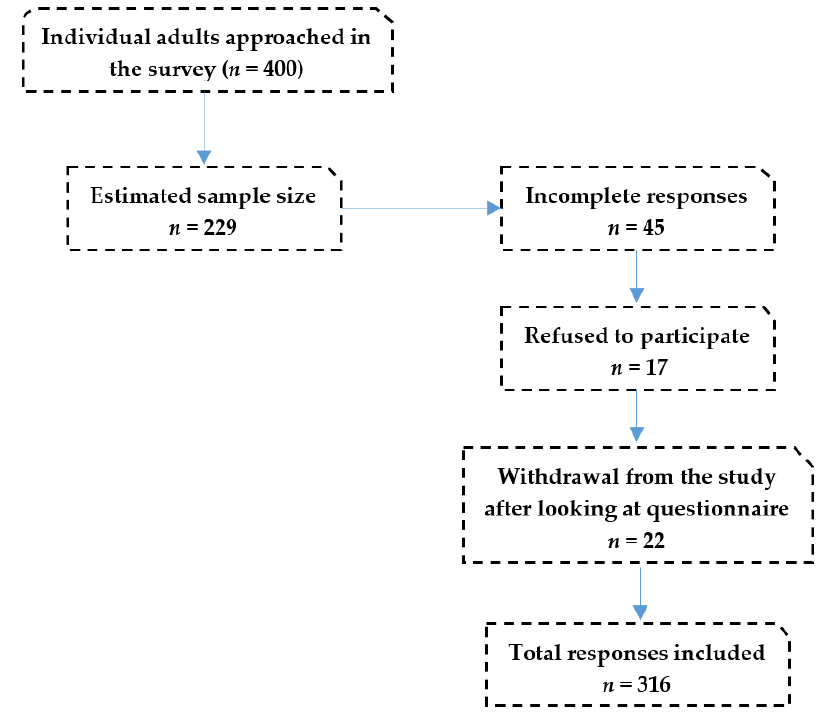
Figure 1. Flowchart of participant responses.